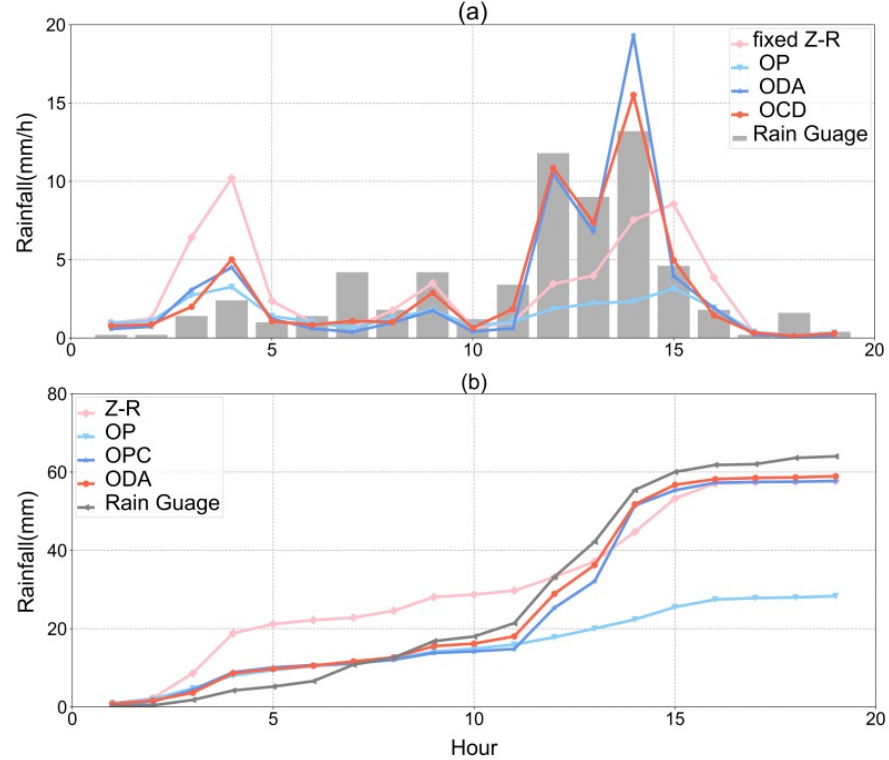
Figure 7. Time-by-time evolutionary characteristics of 4 QPE algorithms (rainfall event 5, rain gauge ID:40537250), ( a ) hourly, ( b ) cumulant. ID:40537250), ( a ) hourly, ( b )